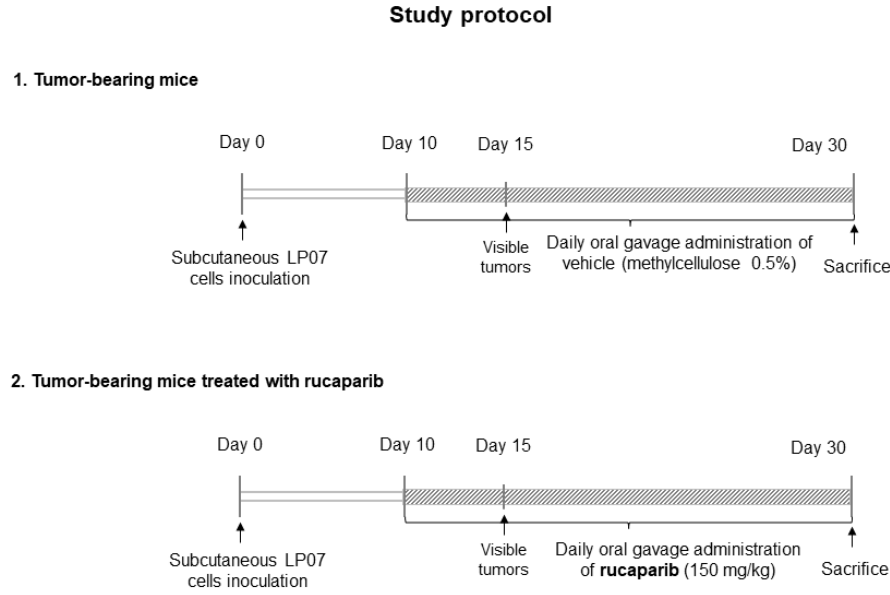
Figure 8. Schematic timeline representation of the study protocol in the two study groups.